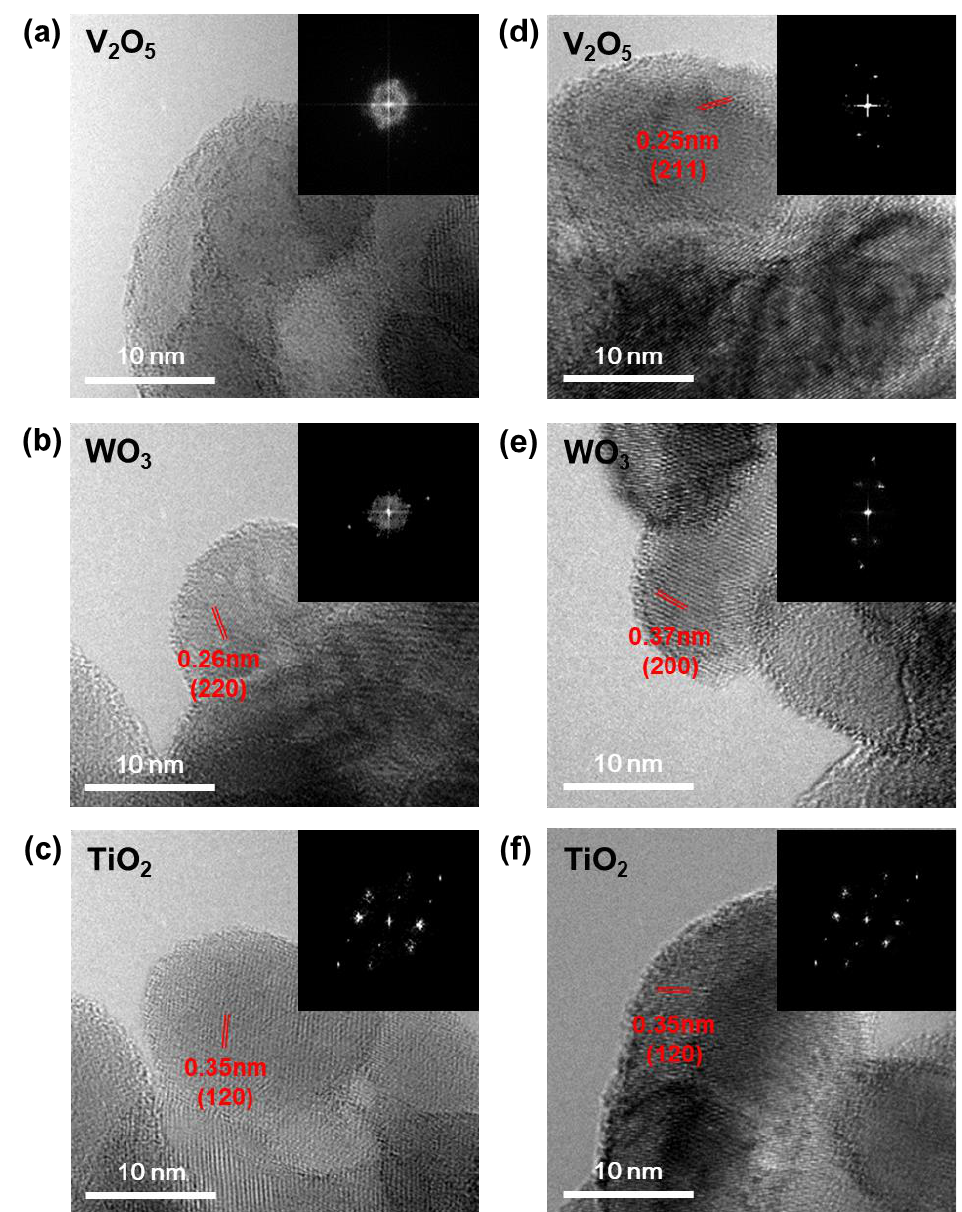
Figure 3. TEM images and SAED patterns (inset) of the V 2 O 5 -WO 3 /TiO 2 prepared by ( a – c ) one-sided heating and ( d – f ) isotropic heating methods.